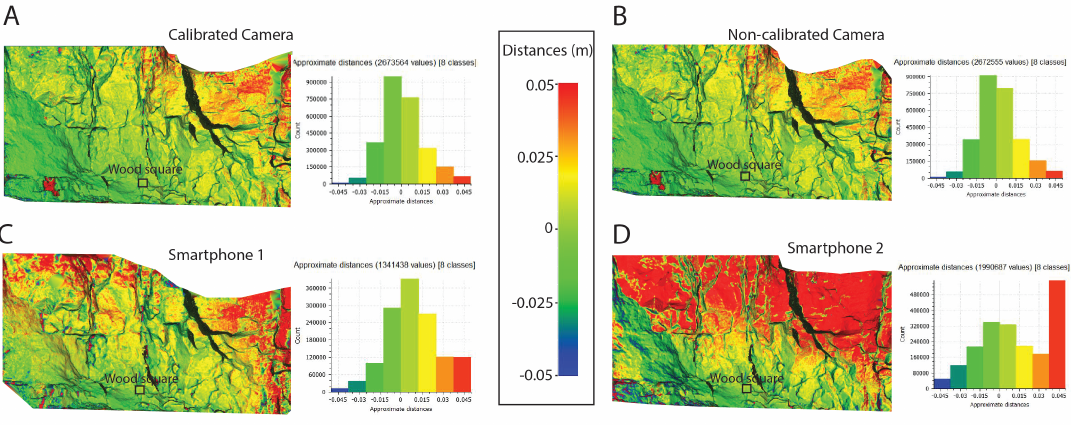
Figure 10. Comparison between LS and DP with a calibrated digital camera ( A ), non-calibrated digital camera ( B ), smartphone 1 ( C ) and smartphone 2 ( D ). All models were georeferenced using the three targets 1, 2, and